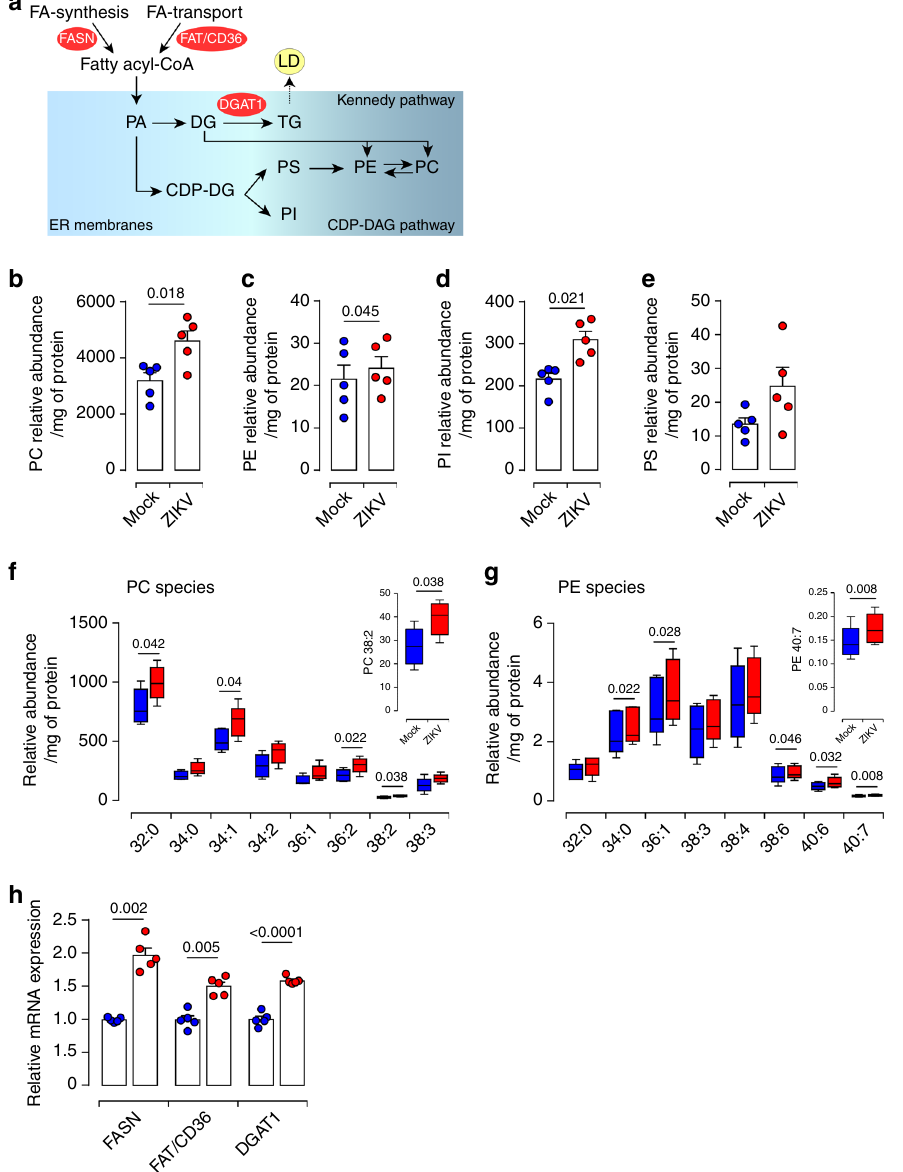
Fig. 2 ZIKV infection perturbs the phospholipid placental pro fi le. a Simpli fi ed schematic overview of the phospholipid (PL) metabolism pathways. Fatty acid (FA), phosphatidic acid (PA), cytidine diphosphate diacylglycerol (CDP-DAG). Lipid droplet (LD). Fatty acid synthase (FASN) catalyzes FA de novo lipid synthesis. The transporter FAT/CD36 assists in FA uptake from the exogenous environment. The ER-resident diacylglycerol acyltransferase 1 (DGAT1), an essential enzyme for LD biogenesis, catalyzes the fi nal step in TG biosynthesis. b – g PLs were extracted from mock or ZIKV-infected placenta explants 5 dpi and subjected to LC-MS/MS analysis. Quanti fi cation of PL species was achieved by comparison of the peak area of individual species relative to their class-speci fi c internal standards. Values are normalized based on the protein level for each sample. The relative abundance of PL species is calculated as the sum of subspecies within different subgroups. b Phosphatidylcholine (PC), ( c ) phosphatidylethanolamine (PE), ( d ) phosphatidylinositol (PI), ( e ) phosphatidylserine (PS). f – g Relative abundance of differentially altered phospholipid subspecies from PC ( f ) and PE ( g ). Boxplot: boxplot medians (center lines), interquartile ranges (box ranges), whisker ranges. h Total RNA extracted from matched mock- and ZIKV-infected fi rst trimester placentas at 5 dpi. The mRNA expression levels were determined by qRT-PCR. Mock-infected placenta (blue) and ZIKV-infected (red). Results are presented as mean values ± SEM of fi rst trimester placentas from fi ve independent donors. P values are computed using paired two-tailed Student ’ s t test. Source data are provided as a Source Data fi